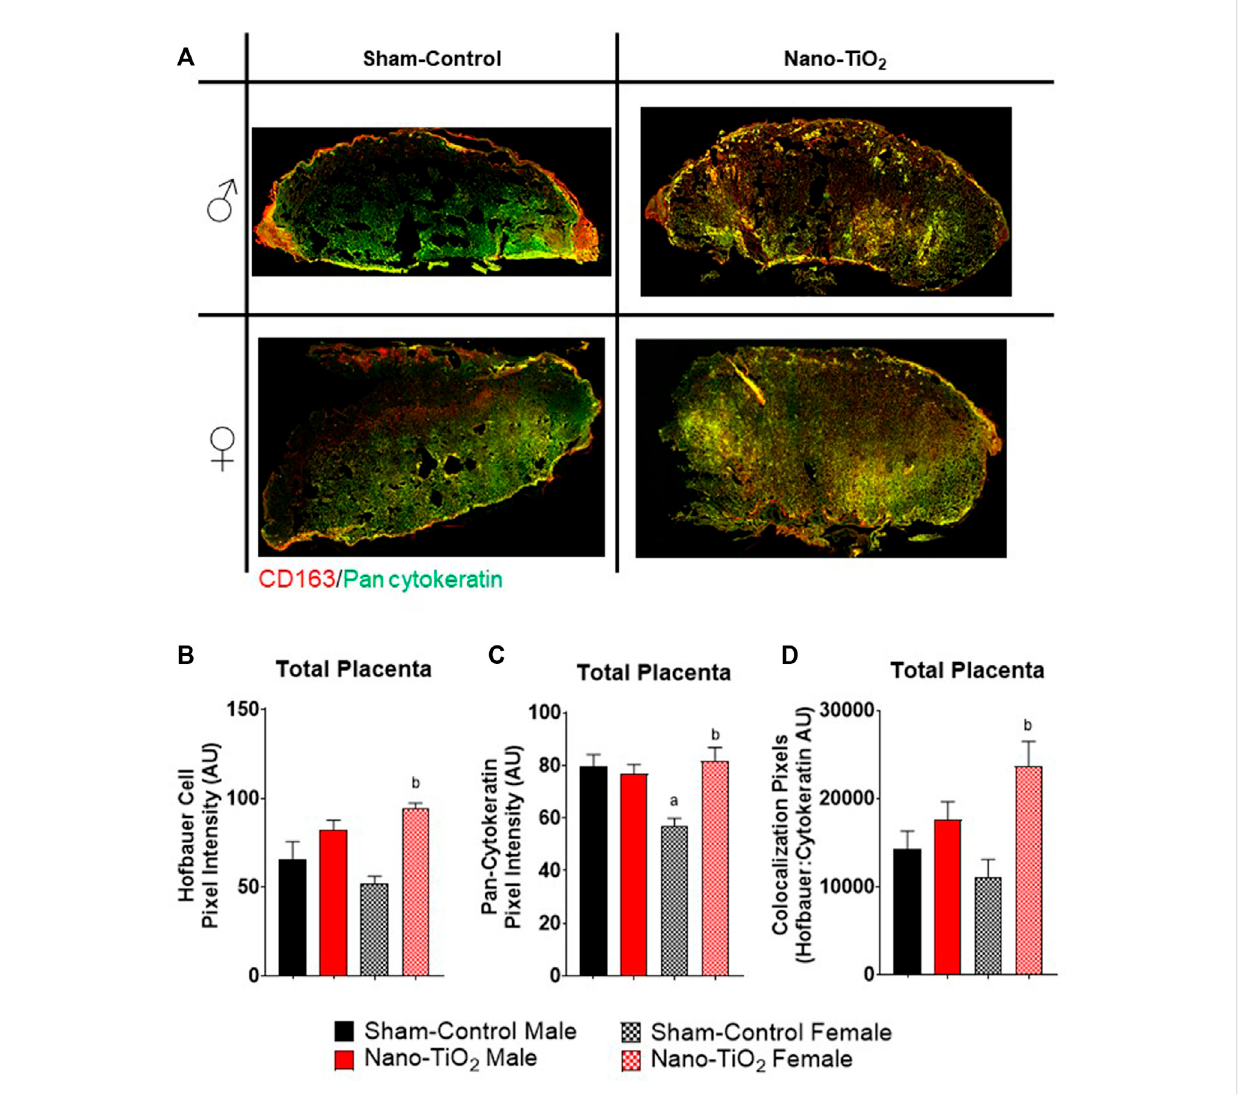
Whole Placental Immunohistochemistry. Total placental fl uorescence intensity and colocalization of anti-CD163 and anti-pan cytokeratin was assessed after maternal nano-TiO 2 inhalation exposure. (A) Representative placental images for each group. (B) Total placental Hofbauer cell pixel intensity. (C) Total placental pan-cytokeratin pixel intensity. (D) Total placental colocalization of Hofbauer: Pan-cytokeratin. Sham-control males (n = 5), sham-control females (n = 5), nano-TiO 2 males (n = 5), and nano-TiO 2 females (n = 5). a, p ≤ 0.05 vs sham-control fetal male. b, p ≤ 0.05 vs sham- control fetal